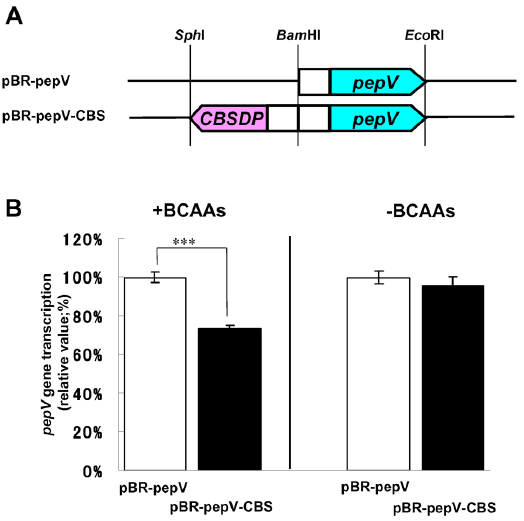
Figure 3. Transcriptional regulation by the CBS domain protein. Schematic drawing of the expression plasmid (A). The pepV gene including 500 bp of upstream sequence was expressed in E. coli HB101 cells carrying pBR-pepV. The gene encoding the CBS domain protein was also co-expressed with the pepV gene in E. coli HB101 harboring pBR - pepV-CBS. White boxes show about 500 bp of DNA upstream of the genes. CBSDP and pepV indicate the ORF of each gene. pepV gene transcription in the E. coli transformant was quantified by RT- PCR with total RNA from E. coli cultured with or without 0.4% casamino acids and 10 mM BCAAs (B). The glyceraldehyde 3-phosphate dehydrogenase ( GAPDH ) gene (gapRTF, gapRTR) was used as the internal reference. Error bars indicate standard deviations. Statistical analysis of the data from triplicate experiments was conducted using the Student’s t test. *** P , 0.001.